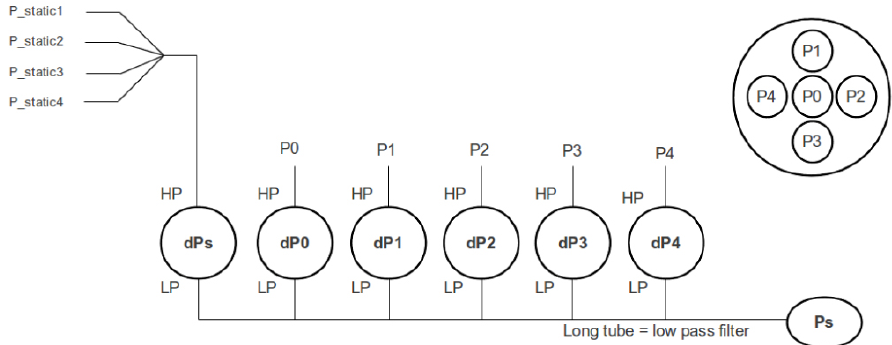
Fig. 5. Alternative tubing setup without branches as used in MASC. The pressure transducer measurements d Pi are differential readings of all single port pressures of the probe ( P 0– P 4 and P static , high pressure, HP) compared to one common reference port (low pressure, LP).